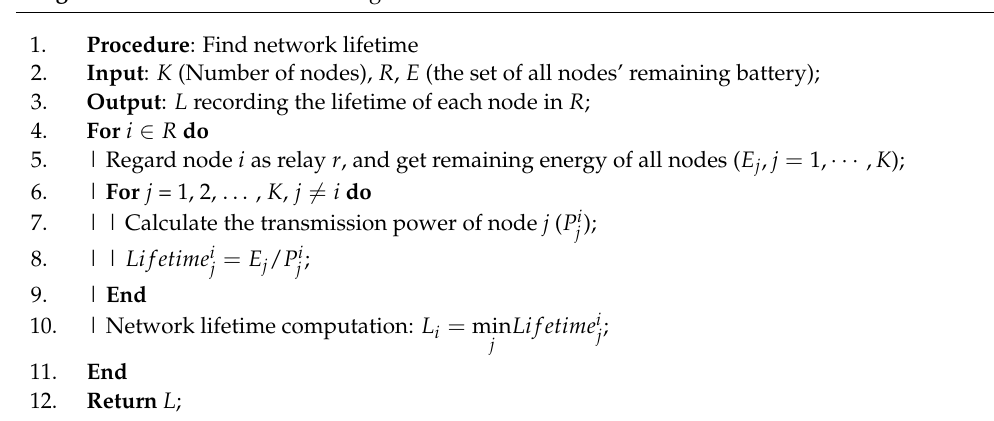
Algorithm 2: Predict the remaining lifetime of the